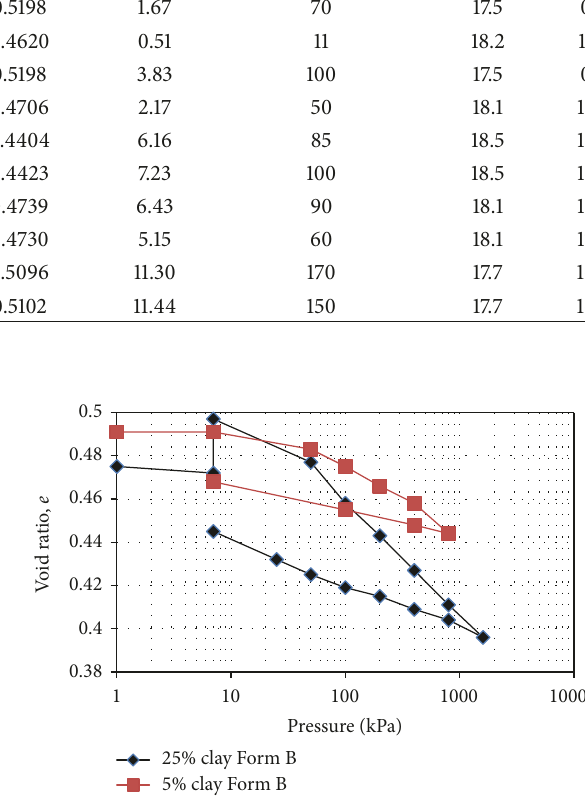
Figure 7: Swell-compressibility profiles for two selected clay ratios of Form B clay.